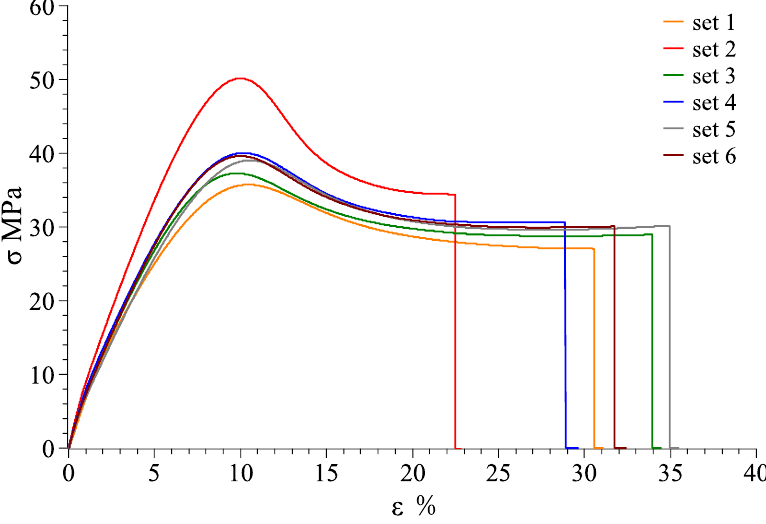
Figure 27. VeroWhitePlus, DM8510 stress–strain curve for the Y-axis (6 specimens).